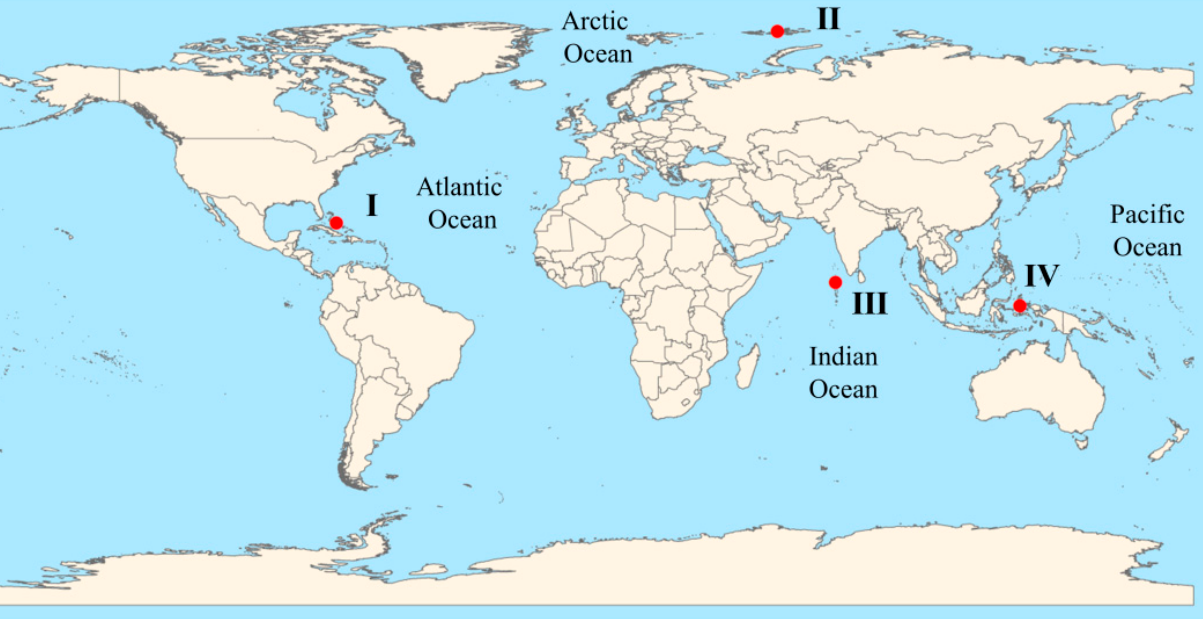
Table A1. The evaluation results of two island datasets (GSV and OSM), in terms of the accuracy measures.